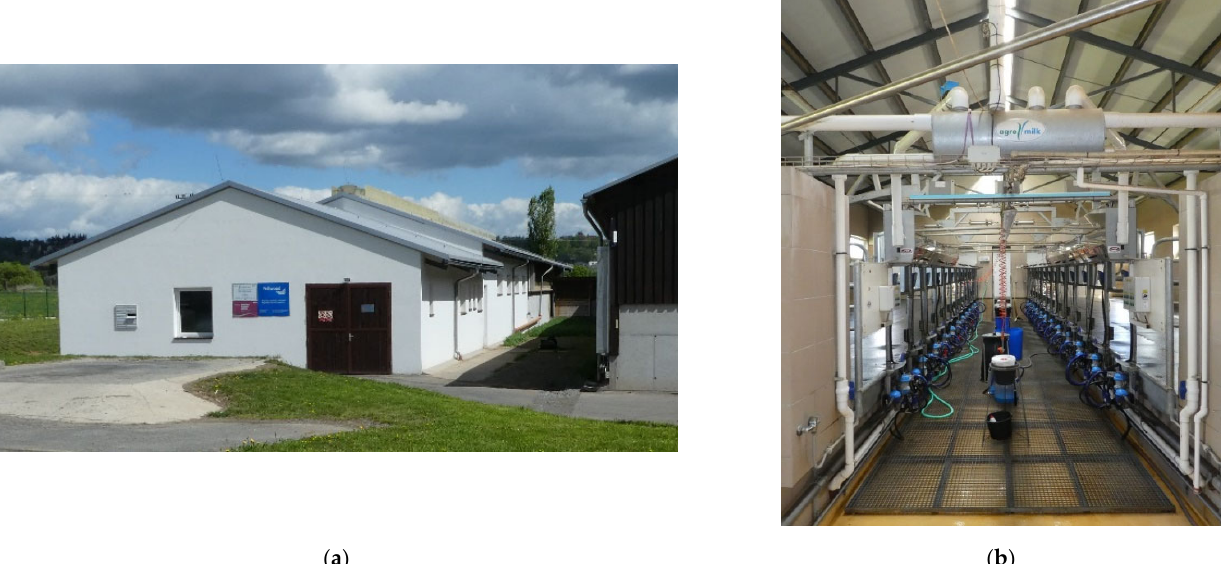
Figure 2. The herringbone milking parlor (MP): ( a ) exterior view; ( b ) the interior of the milking